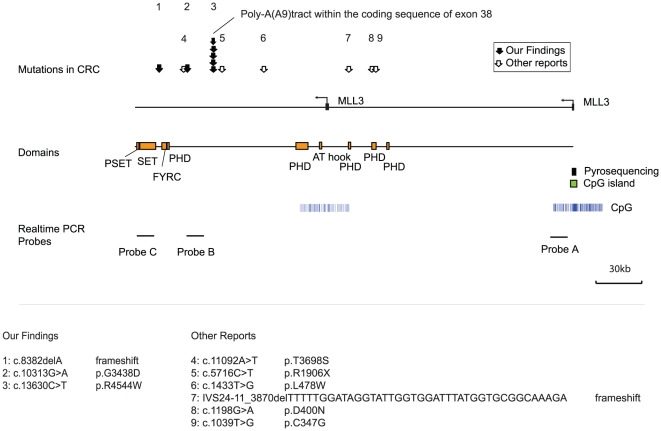
Genomic structure of the human MLL3 gene.MLL3 is transcribed from two separate promoters (arrows), and the promoter for the larger transcript contains a CpG island while there is none in the truncated form. The locations of mutations found in this and previous reports are indicated by arrows. Each arrow corresponds to a single case with a mutation, except for the one region with multiple arrows, which corresponds to the polyA tract. MLL3 gene encodes a predicted protein of 4911 amino acids containing two plant homeodomains (PHD), an ATPase alpha/beta signature, a high mobility group, a SET (Suppressor of variegation, Enhancer of zeste, Trithorax) and two FY (phenylalanine tyrosine) rich domains. Each of the mutations in primary samples were shown under the genome structure schema in Figure 1.